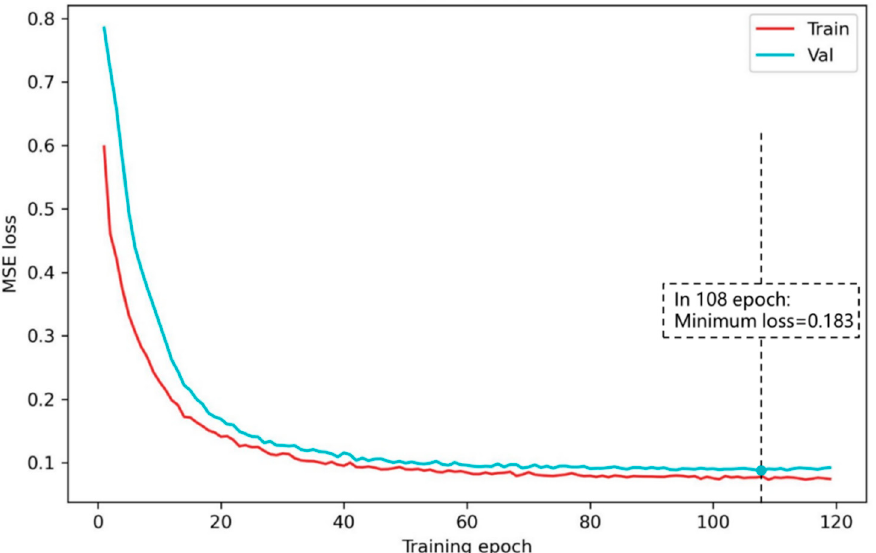
Figure 5. The decrease in the MSE loss value during training at each epoch iteration; the red curve is the training loss, while the blue curve is the validation loss. The minimum validation loss occurs at the 108th epoch with a loss value of 0.183.